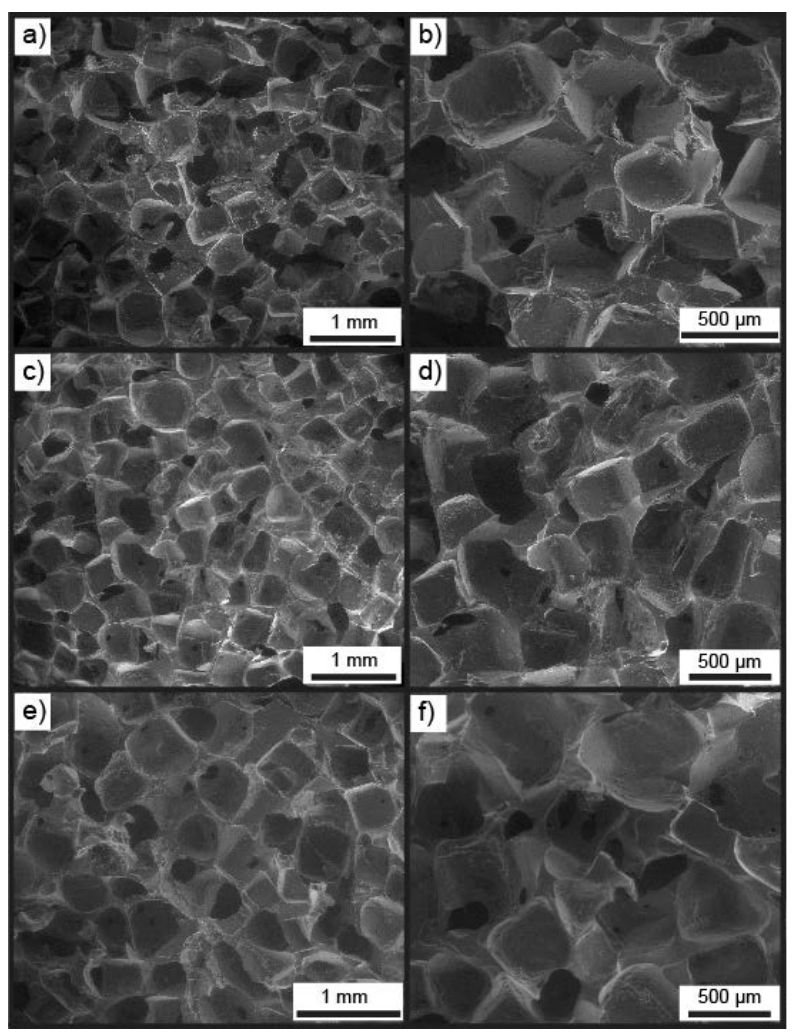
Figure 2. Enviro-SEM images of ( a , b ) Suc-PEH 2 , ( c , d ) Seb-PEH 2 and ( e , f ) Tms-PEH 2 .